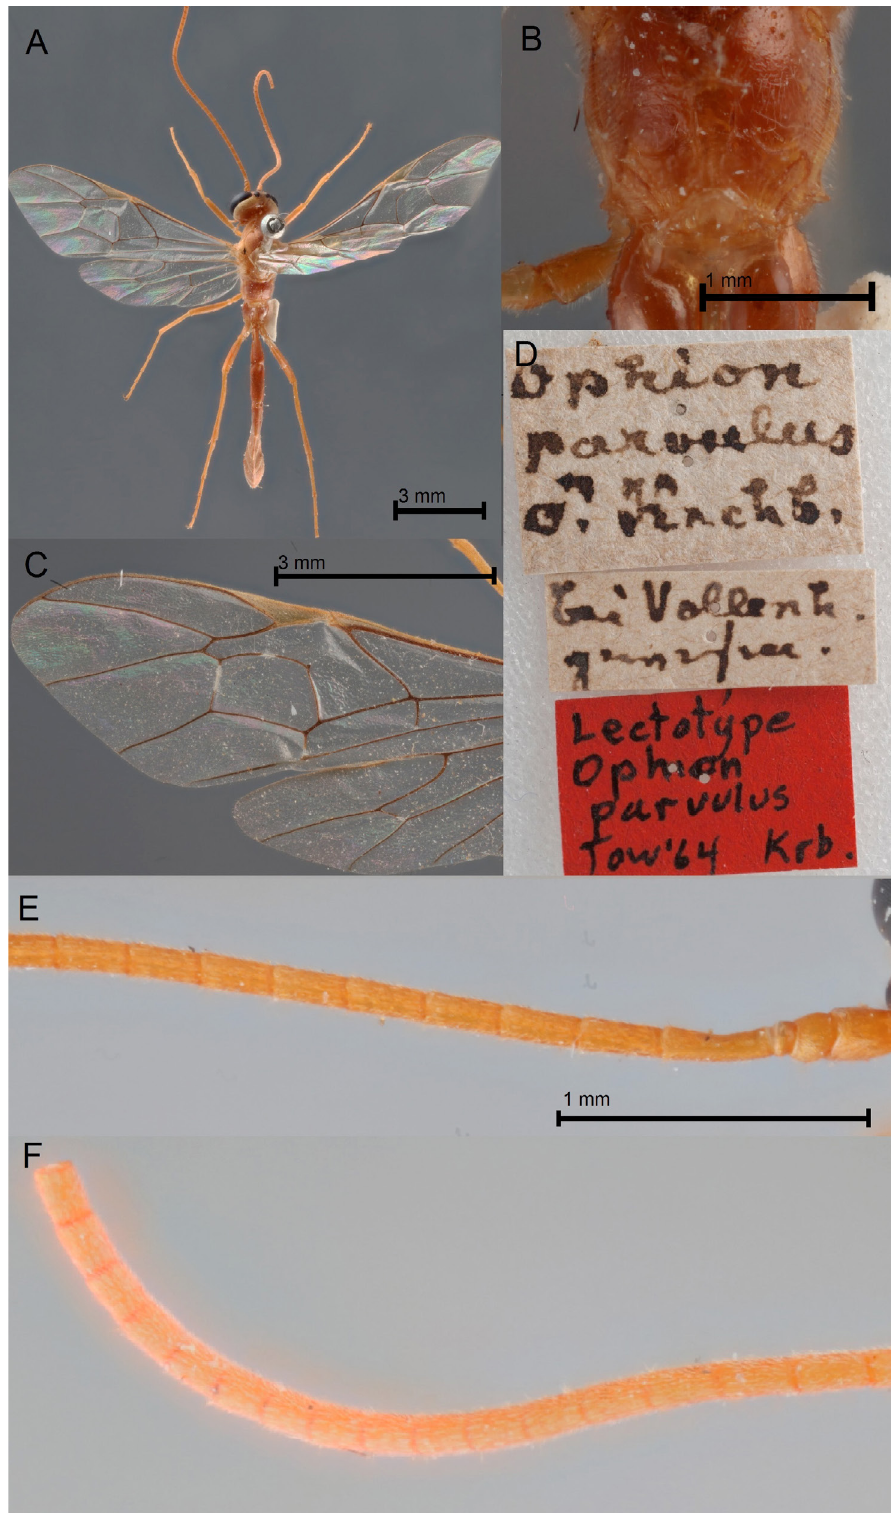
Fig. 51. Ophion parvulus Kriechbaumer, 1879, lectotype, ♂ (ZSM). A . habitus, dorsal view. B . Propodeum, postero-dorsal view. C . Fore wing. D . Labels. E . Basal flagellomeres. F . Subapical